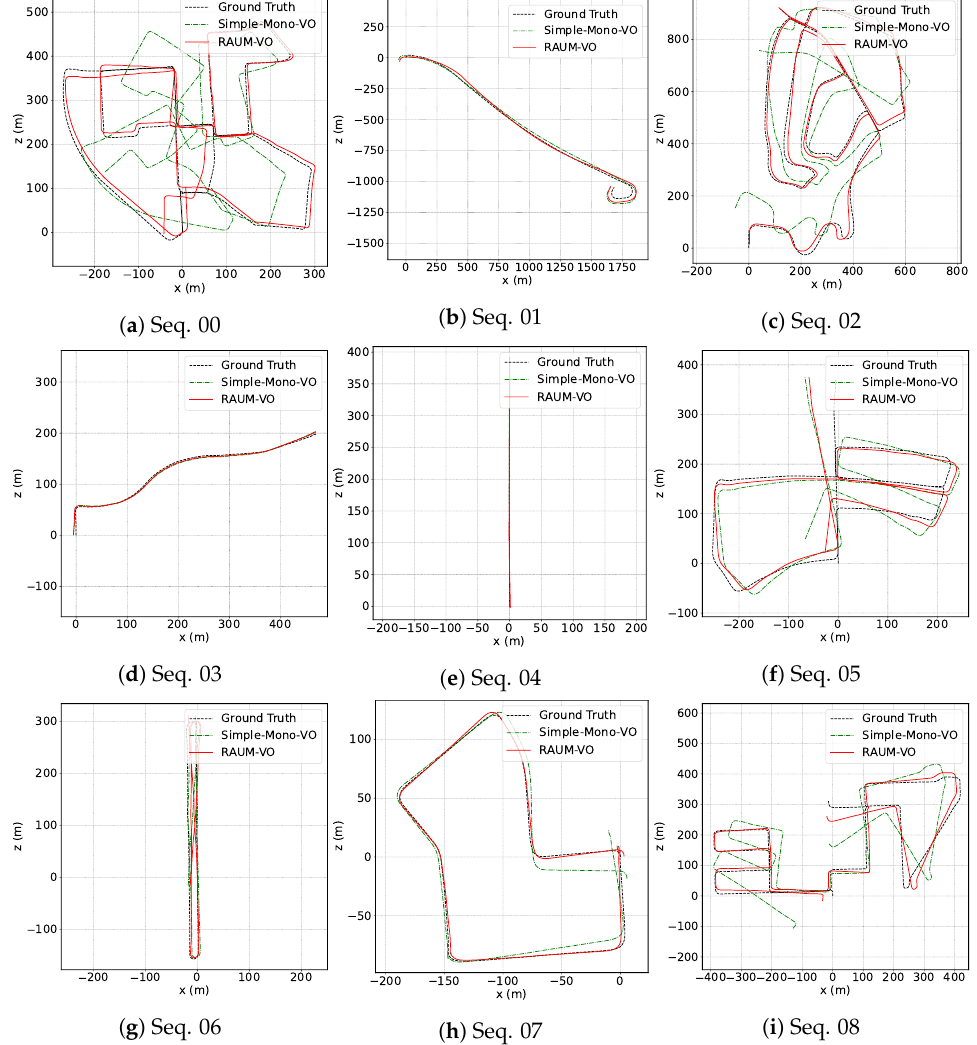
Figure 3. KITTI train trajectories. Estimated trajectories for the KITTI odometry sequences from 00 to 08. Poses are given in camera frame. Thus, positive x means right direction and positive z means forward. Best viewed in colors.